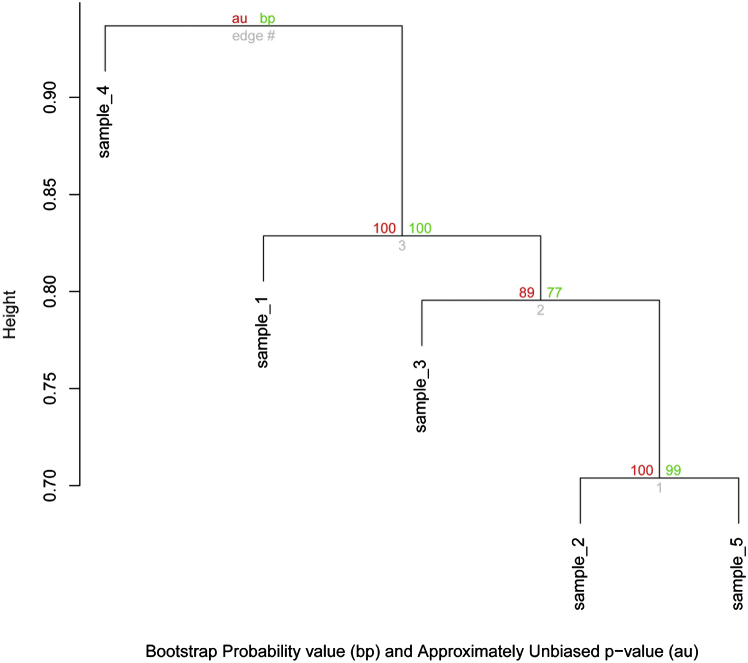
Cluster dendrogram of methylation pattern with bootstrap resampling.